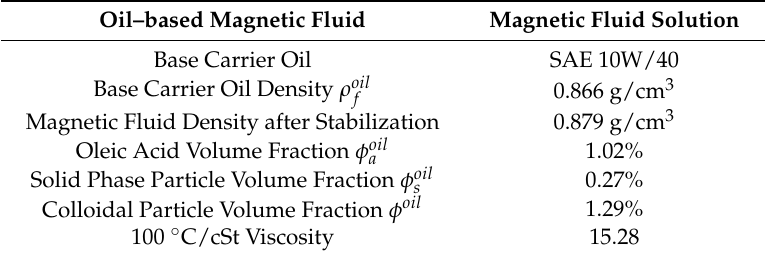
Table 1. Oil–based magnetic fluid properties Oil–based Magnetic